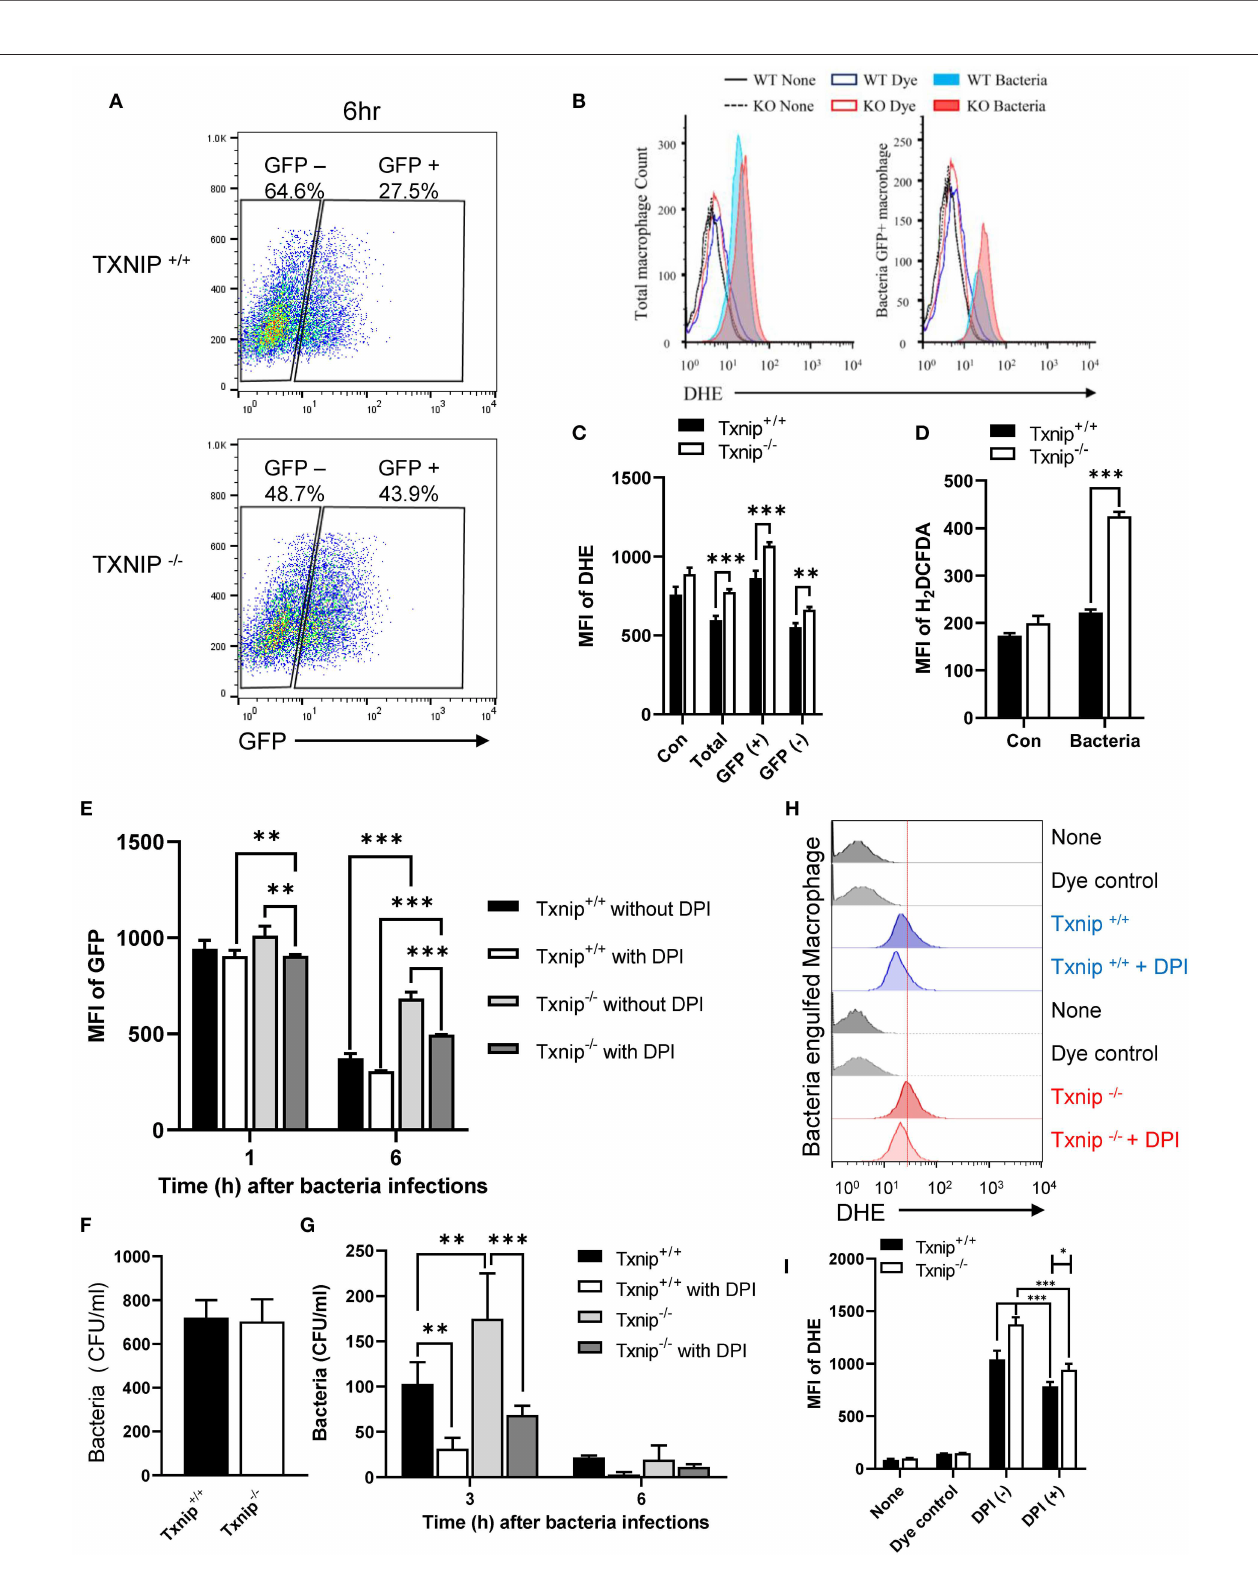
FIGURE 3 | Thioredoxin-interacting protein (TXNIP) regulates the level of superoxide in macrophages after the engulfment of E. coli . (A) FACS analyses showing the proportion of wild-type (WT) and Txnip knockout (KO) mouse peritoneal macrophages that retained GFP-expressing E. coli 6h after treatment with GFP-expressing E. coli at a multiplicity of infection (MOI) of 20. (B) The distribution of WT and Txnip KO mouse peritoneal macrophages based on the intensity of the DHE dye after